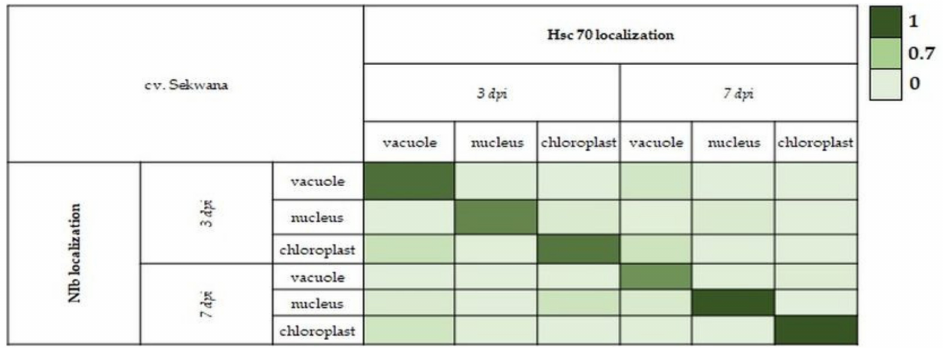
Figure 13. Heat map of PCC for PVY-NIb and HSC70 localization in virus-inoculated Sekwana from 3 to 7 dpi. PCC values are presented pairwise for specific cell compartments at a specific time after virus inoculation and marked with colors from very dark green (PCC = 1) to pale green (PCC =